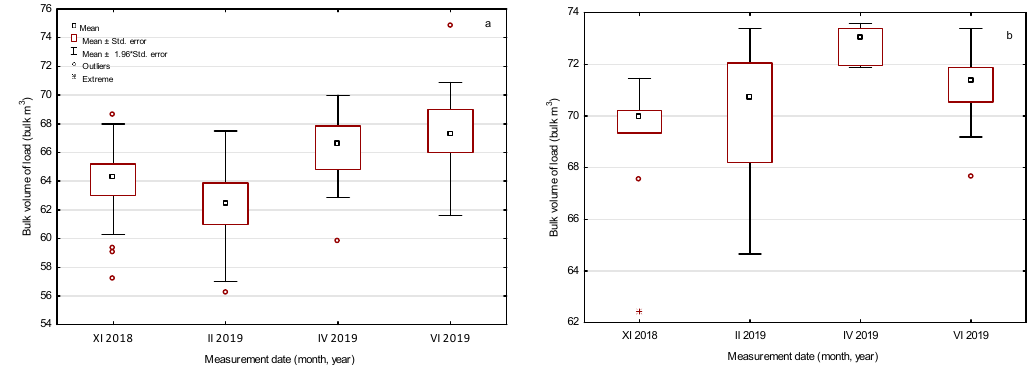
Figure 8. Comparison bulk volume of load values by measurement date for unit A wood chips ( a ); sawdust ( b ).